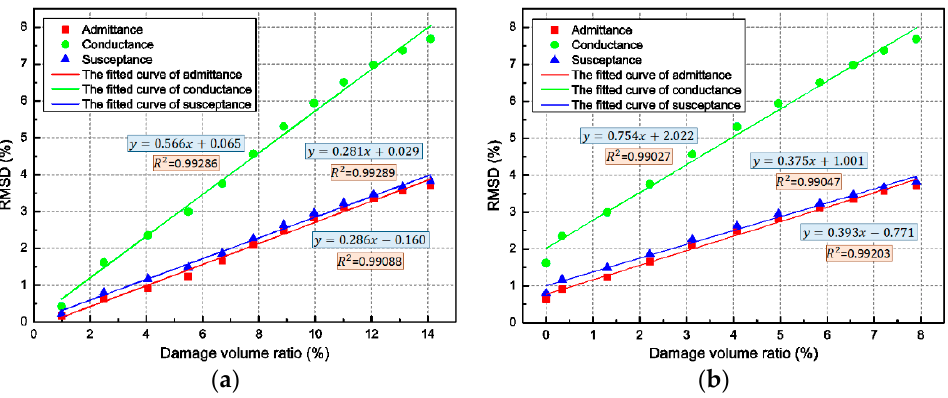
Figure 9. The RMSD based damage volume ratio: ( a ) global damage ( d > 0); and ( b ) local damage ( d > 0.7).